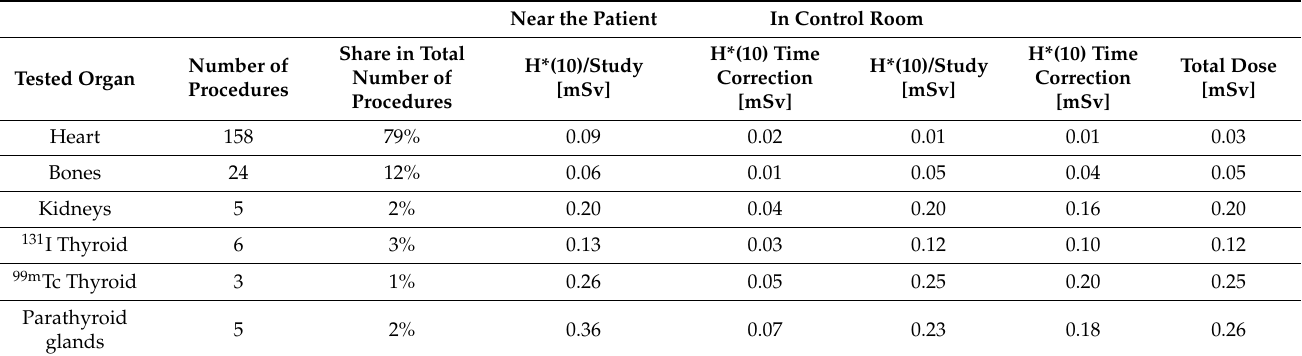
Table 3. Share in the total number of procedures, calculated ambient equivalent doses for a single study and ambient equivalent dose for a study including time spent in each of the locations. Near the Patient In Control